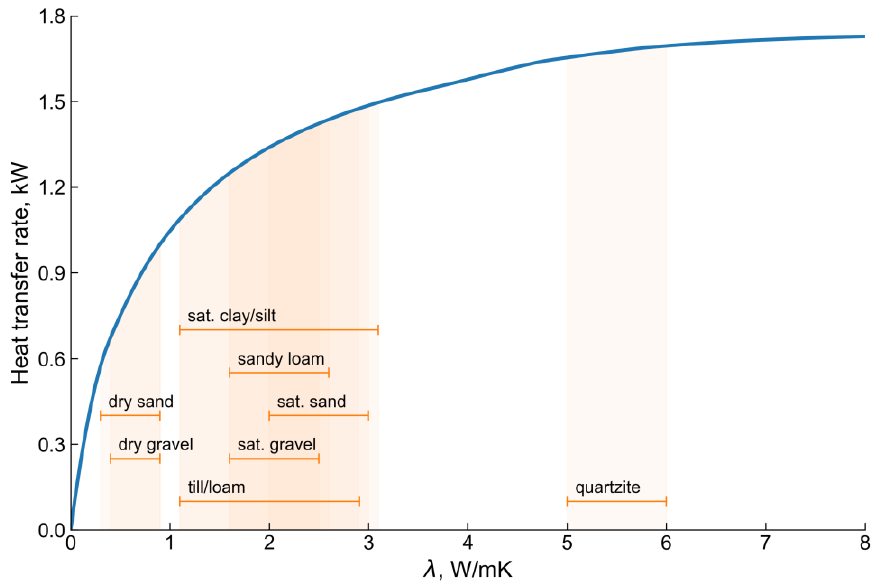
Figure 18. Dependence of the heat transfer rate on the soil thermal